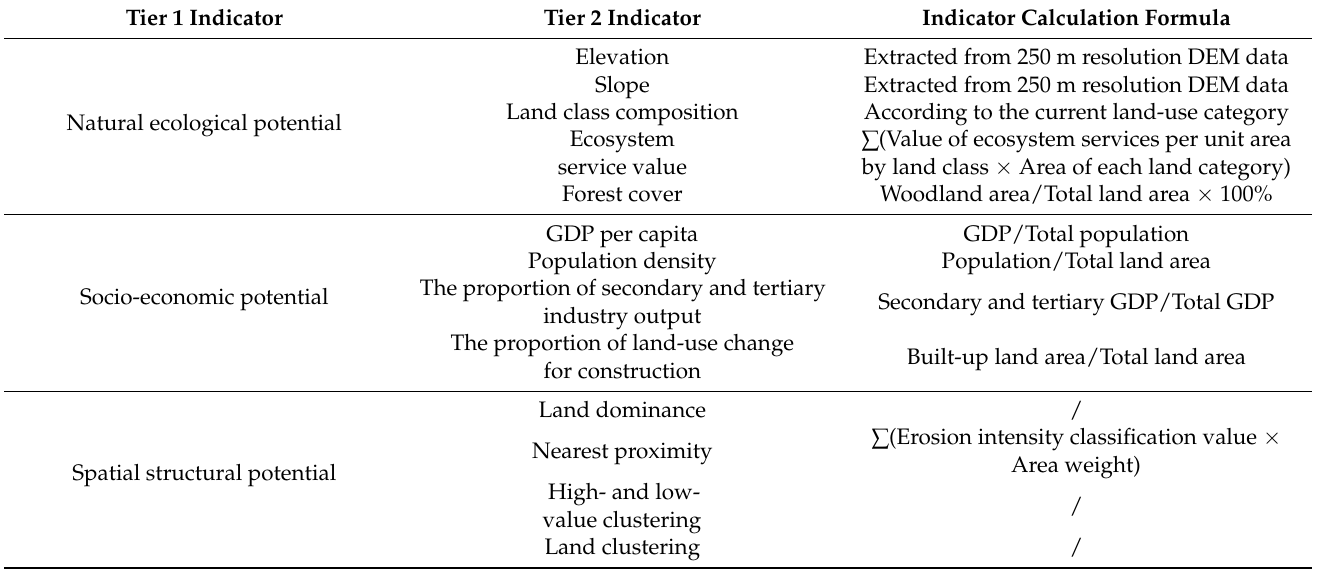
Table 2. Description of evaluation index of land development potential.